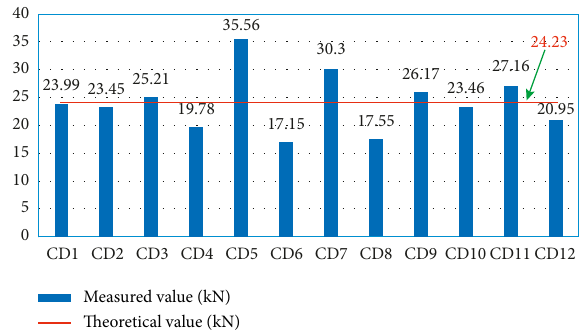
Figure 20: The measured and theoretical axial force values of each measuring